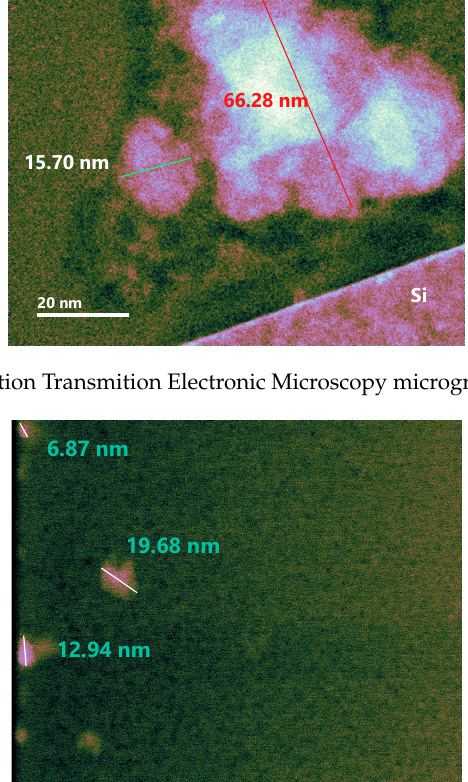
x film. Nanomaterials 2020 , 10 , x FOR PEER REVIEW